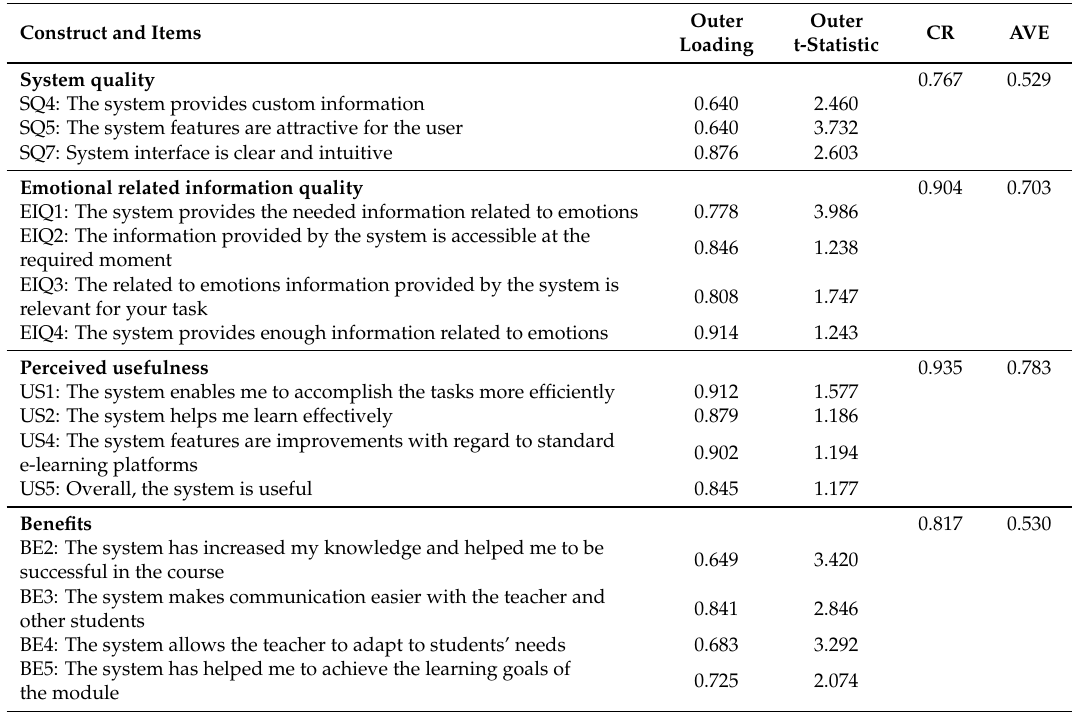
Table 2. Internal consistency and convergent